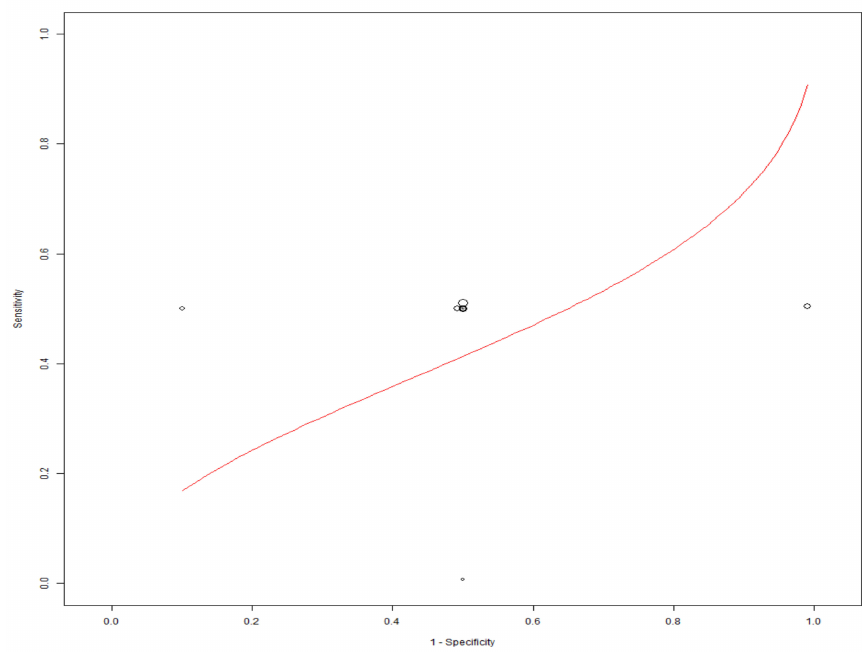
Figure 4. ROC graph of the included studies of mobile-linked POC diagnostic devices.